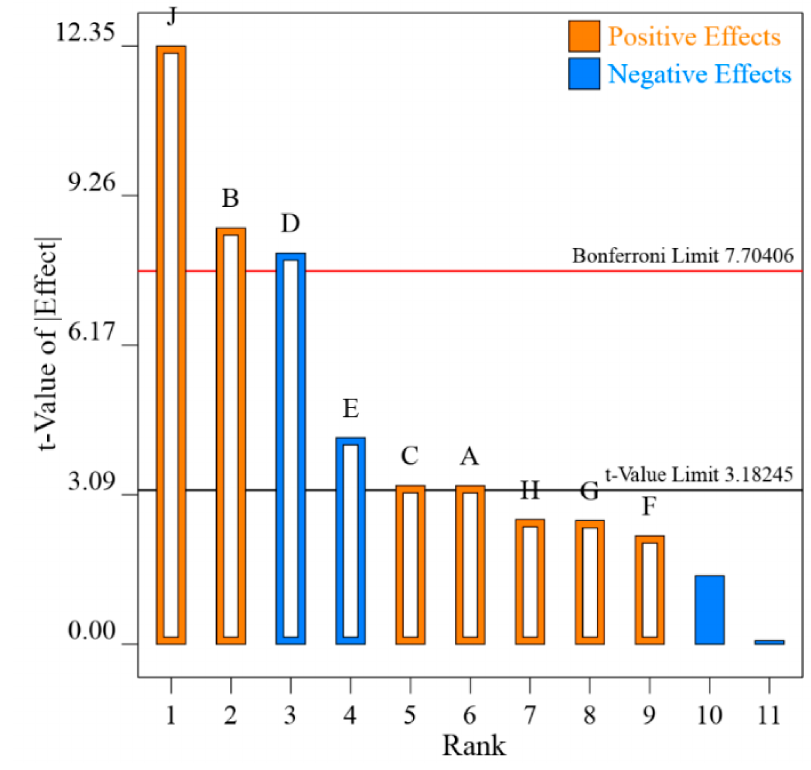
Figure 3. Pareto chart of parameters on